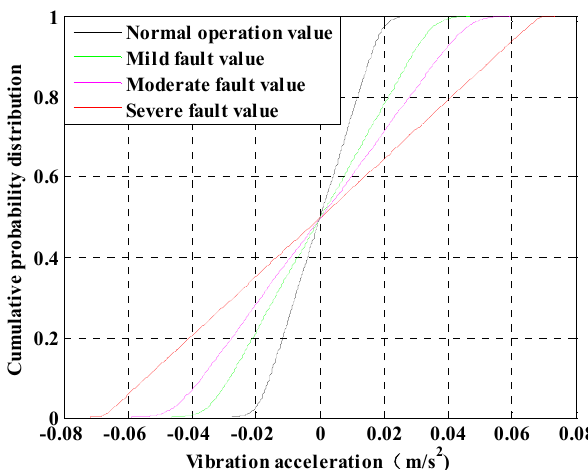
6 of 15 Figure 2. Transformer vibration signal Frequency-Band-Energy (FBE) Histogram. However, the energy spectrum analysis of the signal in the conventional vibration method places high demands on noise reduction and separation technology. If the denoising effect or the signal separation result is not good, the vibration signal will be mixed with more high-frequency signals, resulting in incorrect recognition results. Therefore, the method must be optimized to achieve the purpose of the technical application. 3. Optimization Method for Transformer Fault Identification 3.1. Distribution Characteristics of Transformer Vibration Signals Assuming that the vibration signal of the transformer and the distribution of the vibration signal at different signal intervals are random makes it difficult to analyze the vibration signal trend. The cumulative probability distribution characteristics of the transformer vibration signal are analyzed because the cumulative probability distribution function can be used to observe the signal variation trend [26,27]. Figure 3 shows a difference in the cumulative probability distribution curves of the transformer vibration signal at various critical degrees of failure. The properties of the cumulative probability distribution curves were analyzed using the mathematical statistics method. The main content of the